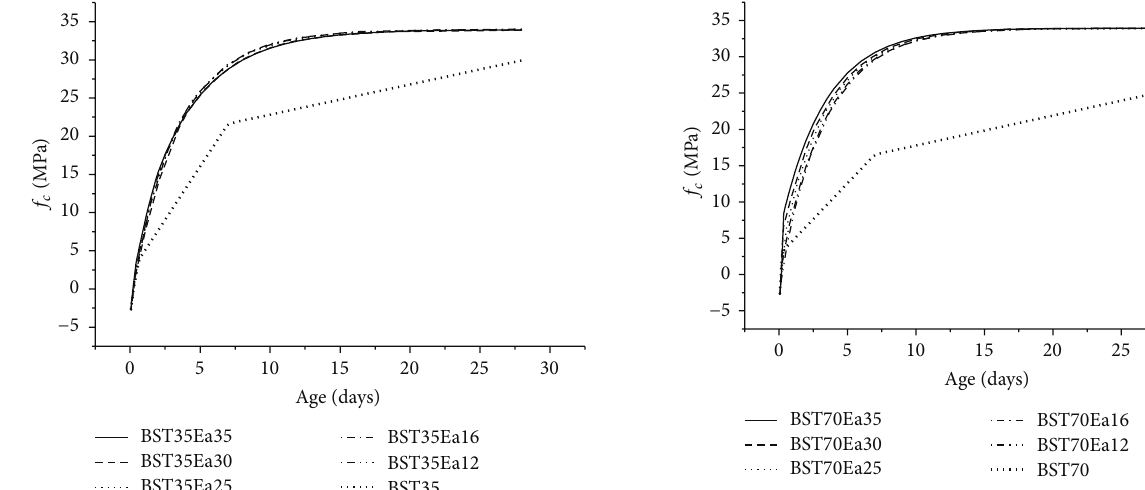
Figure 11: Simulation development of compressive strength with variation of energy of activation and experimental curves of sand concrete heat treated at 35 ∘ C.